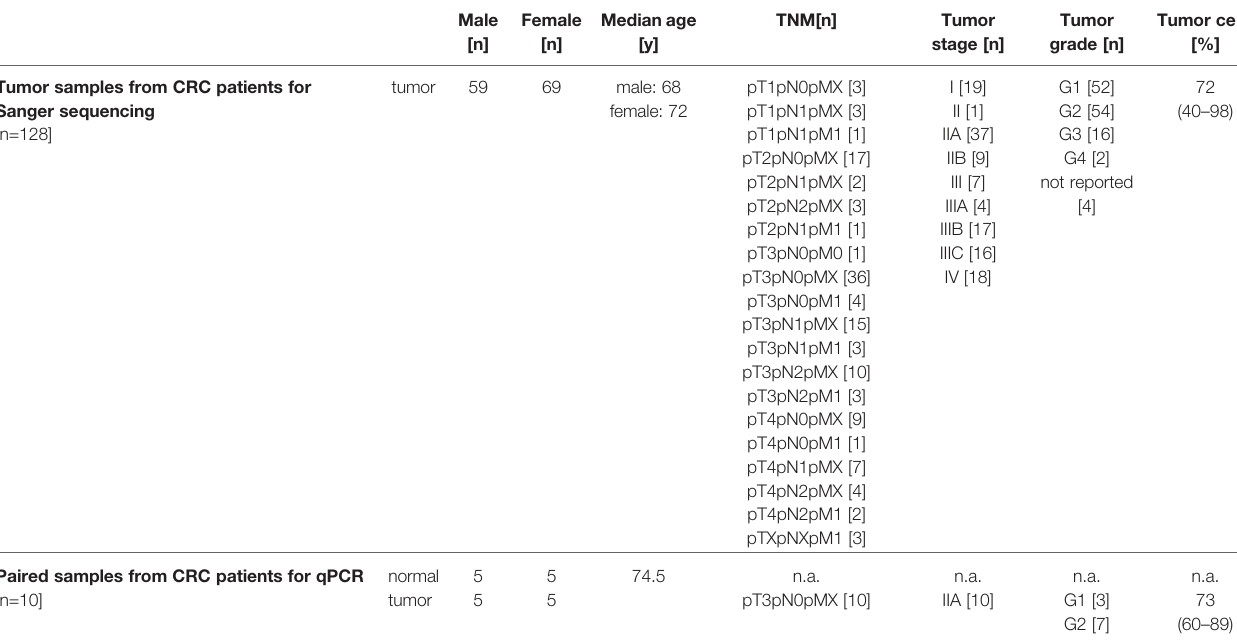
TABLE 1 | Overview of study population.